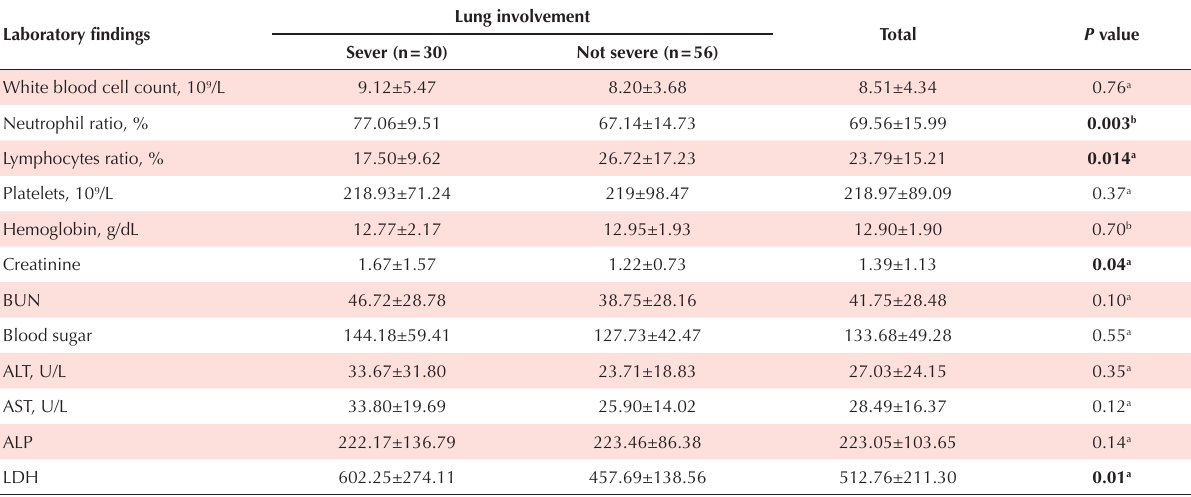
Table 2. COVID-19 patient’s laboratory-test across lung involvement severity Laboratory